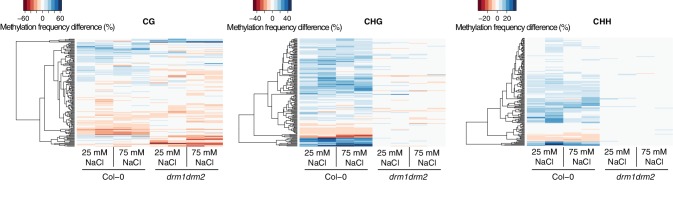
Methylation at hyperosmosis-induced DMRs in drm1drm2 double mutants.Methylation frequency difference in the P1 progeny of salt-stressed Col-0 wild-type and drm1 drm2 plants, separated by sequence context. Methylation frequency differences were calculated by subtracting the methylation frequency for each DMR in the respective sample from its average methylation frequency in the combined P0, P1 and P2 Col-0 control samples. Blue colour indicates hyper-, red colour indicates hypomethylation.